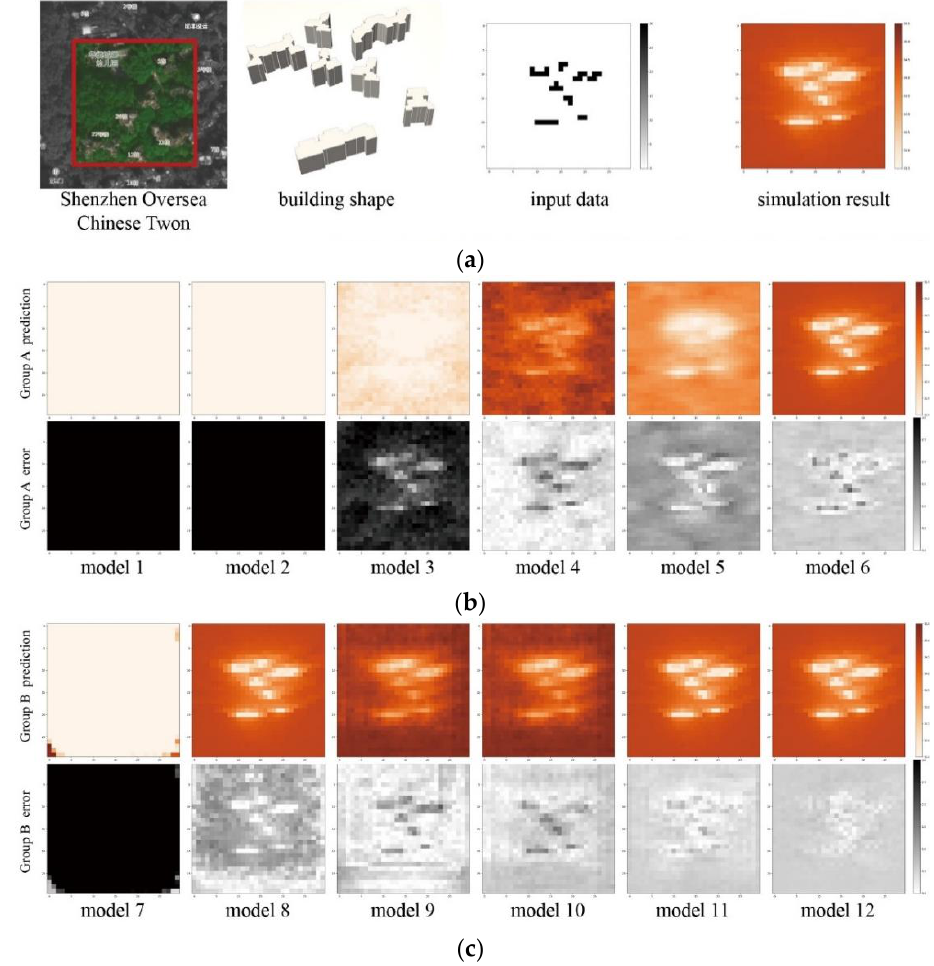
Figure 11. Prediction results of each model for test cases. ( a ) UTCI calculation for a real project; ( b ) 6 Group A and ( c ) 6 Group B models’ prediction values and errors. ( b ) 6 Group A and ( c ) 6 Group B models’ prediction values and